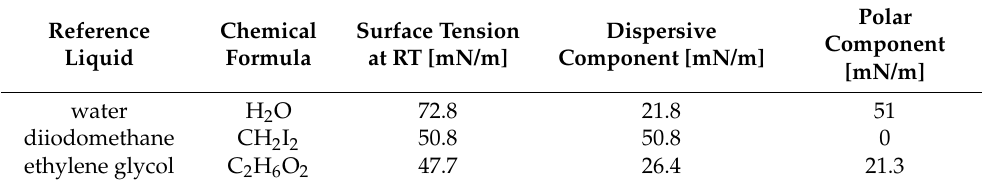
Table 3. Surface tension components of the reference liquids from the substance database of Krüss Advance